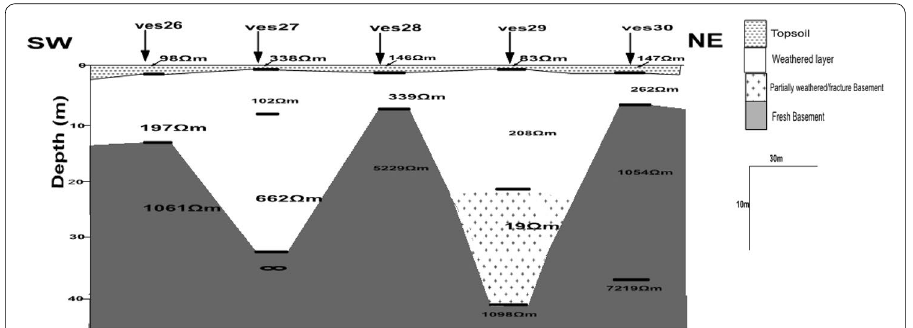
Fig. 9 Geoelectric section along traverse